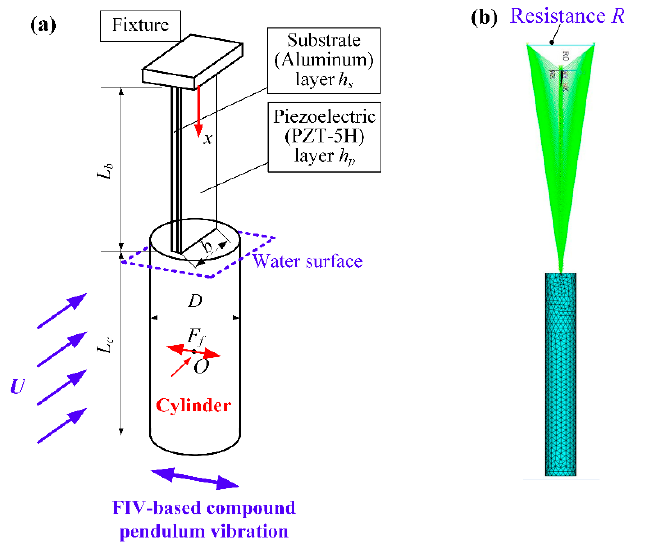
Figure 2. Physical model of the individual PEH: ( a ) Dimension diagram, ( b ) Finite element analytical model.